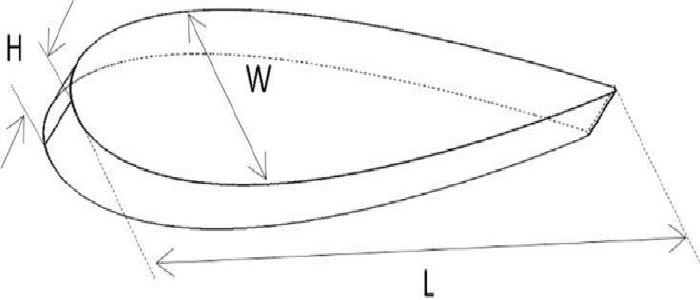
Figure 2. Schematic diagram of a symmetrical airfoil fin [123].